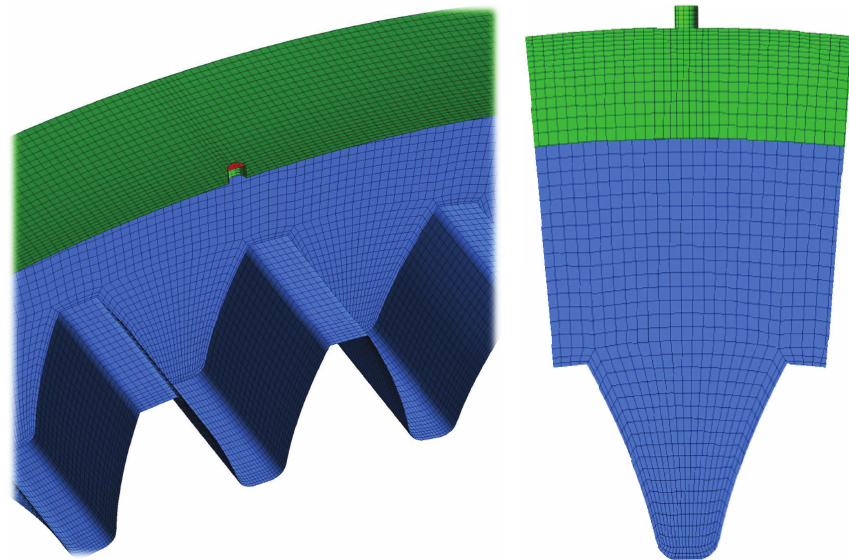
Figure 7: Computational grid of simplified geometry.